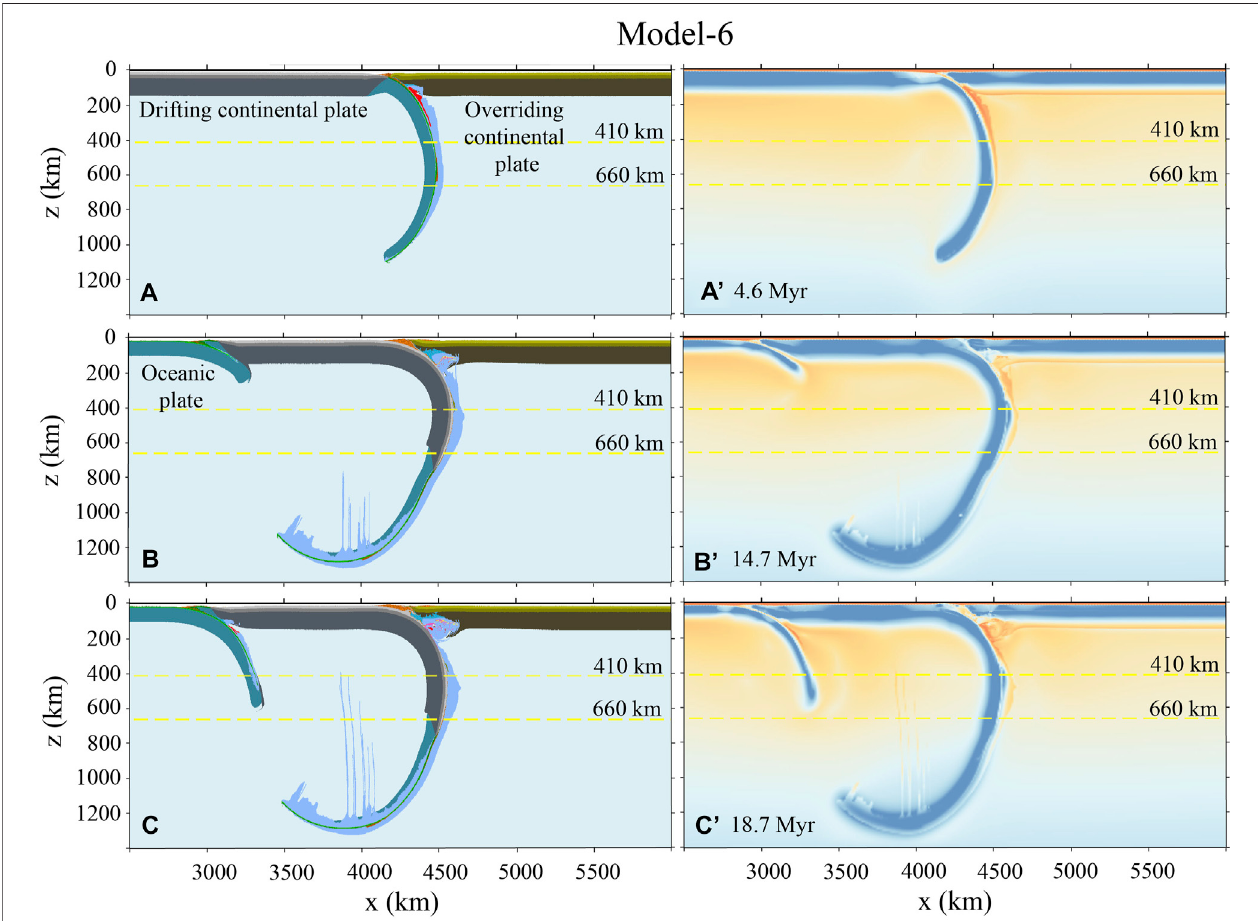
FIGURE 8 | Model-6 evolution with a strong overriding plate. The reconstruction-based convergence rate is applied from 60 Ma ( Figure 2C ). The plastic friction coef fi cient of overriding lithospheric mantle is initially λ · sin ( φ ) (cid:2) 0.6 and will decrease linearly to 0.1 with the accumulated plastic strain to ε plas = 1 ( Supplementary Table S2 and Supplementary Equation S11 in the supporting information), which is the same as that of the underthrusting Indian lithospheric mantle. (A – C) The composition fi eld evolution with the corresponding colorbar is shown in Figure 2A . (A ’ – C ’ ) The effective viscosity evolution with the corresponding colorbar is shown in Figure 2B